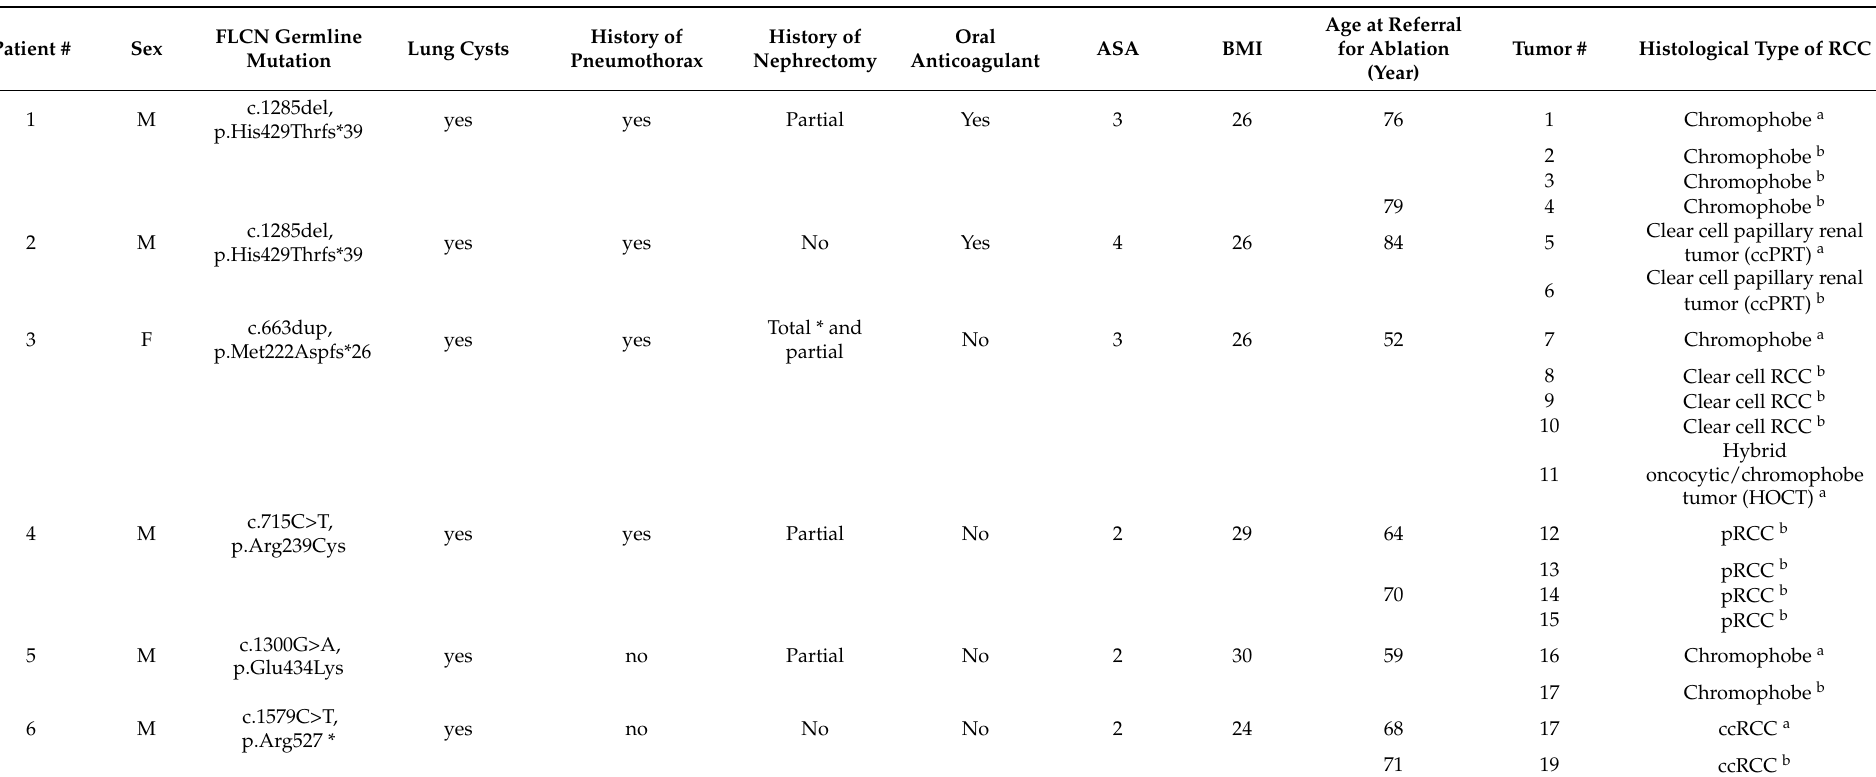
Table 1. Clinical, genetic, and histological characteristics of the six patients with renal cell carcinoma and Birt–Hogg–Dub é